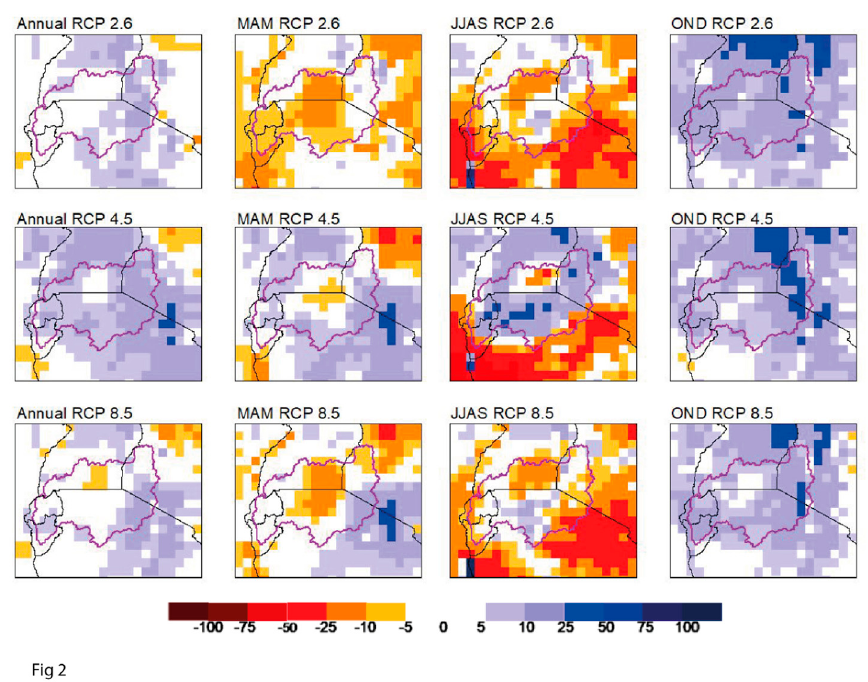
Figure 2. Projected changes in the annual, March–April–May (MAM), June–July–August–September (JJAS), and October–November–December (OND) rainfall components over the Lake Victoria Basin by the 2030s. Each row corresponds to the emission scenarios of RCP 2.6, RCP 4.5, and RCP 8.5.